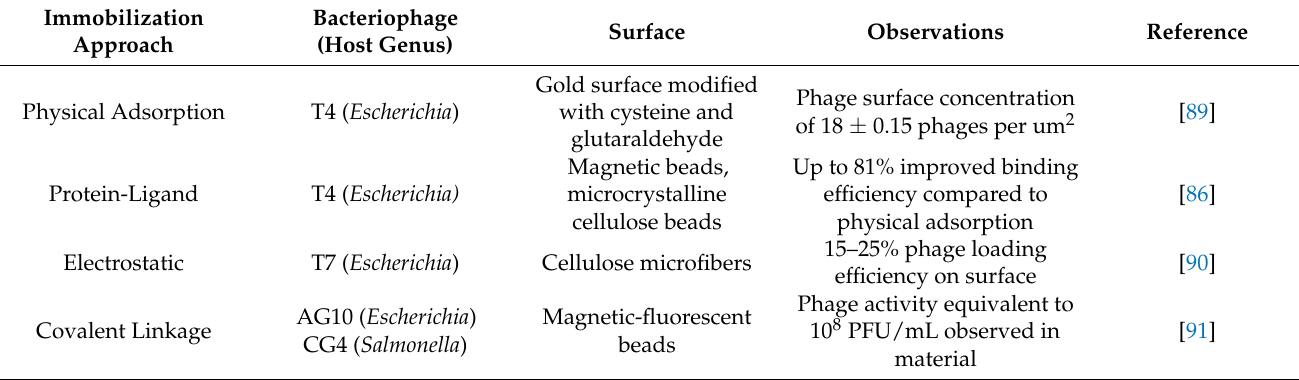
Table 3. Examples of studies involving immobilization of bacteriophages onto